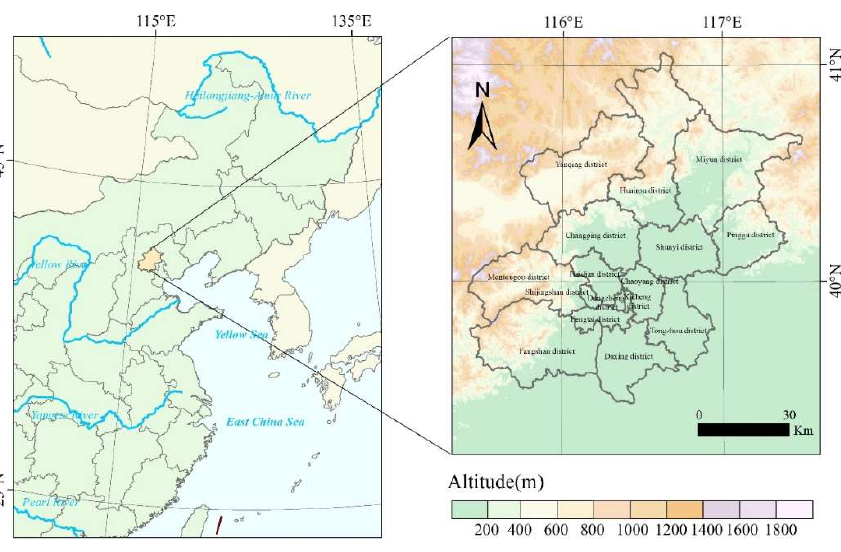
Figure 1. Location of the study area.